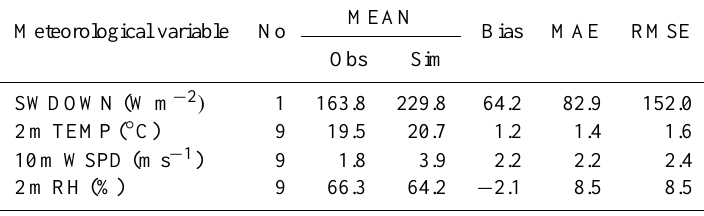
Table 4. Verification statistics of meteorological simulations.